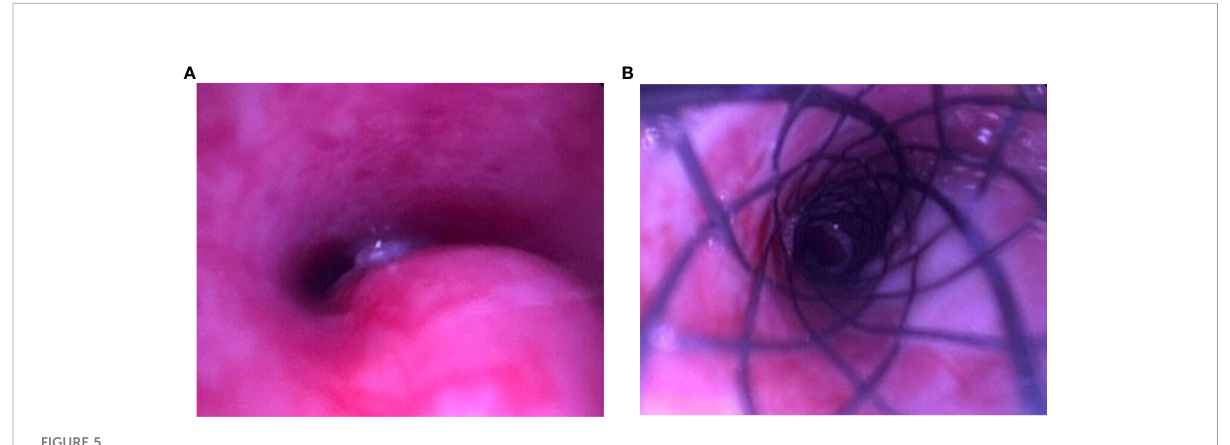
FIGURE 5 Stent implantation. (A) Malignant airway stenosis. (B) Airway